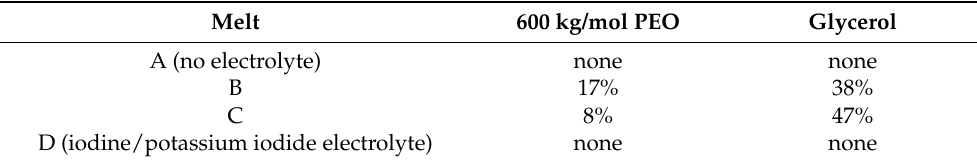
Table 3. Composition of the gel electrolyte of DSSCs used for the melting tests [45] in weight percentage.